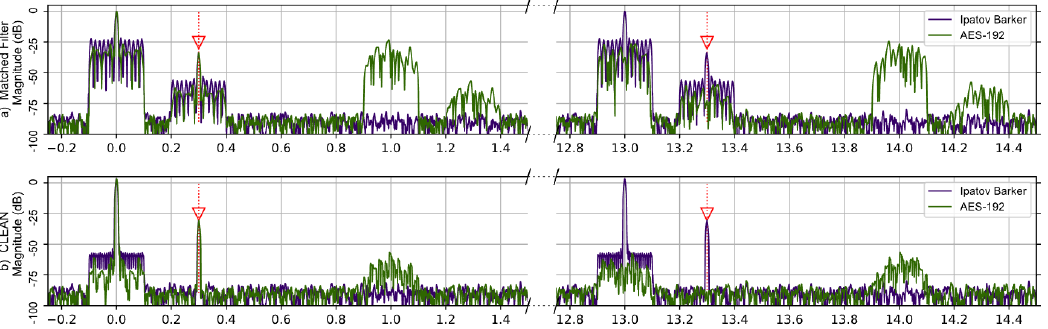
Figure 4. Ipatov–Barker method (Purple) and AES-192 method (Green) matched filter’s response for 78 simulated pulses. ( a ) Top, matched filter’s response before CLEAN. ( b ) Bottom, CLEAN Reconstructed matched filter’s response when applied to both targets. The Ipatov–Barker method begins to repeat after pulse 13, but the AES-192 method does not. The side lobes of the AES-192 method are reduced by CLEAN.